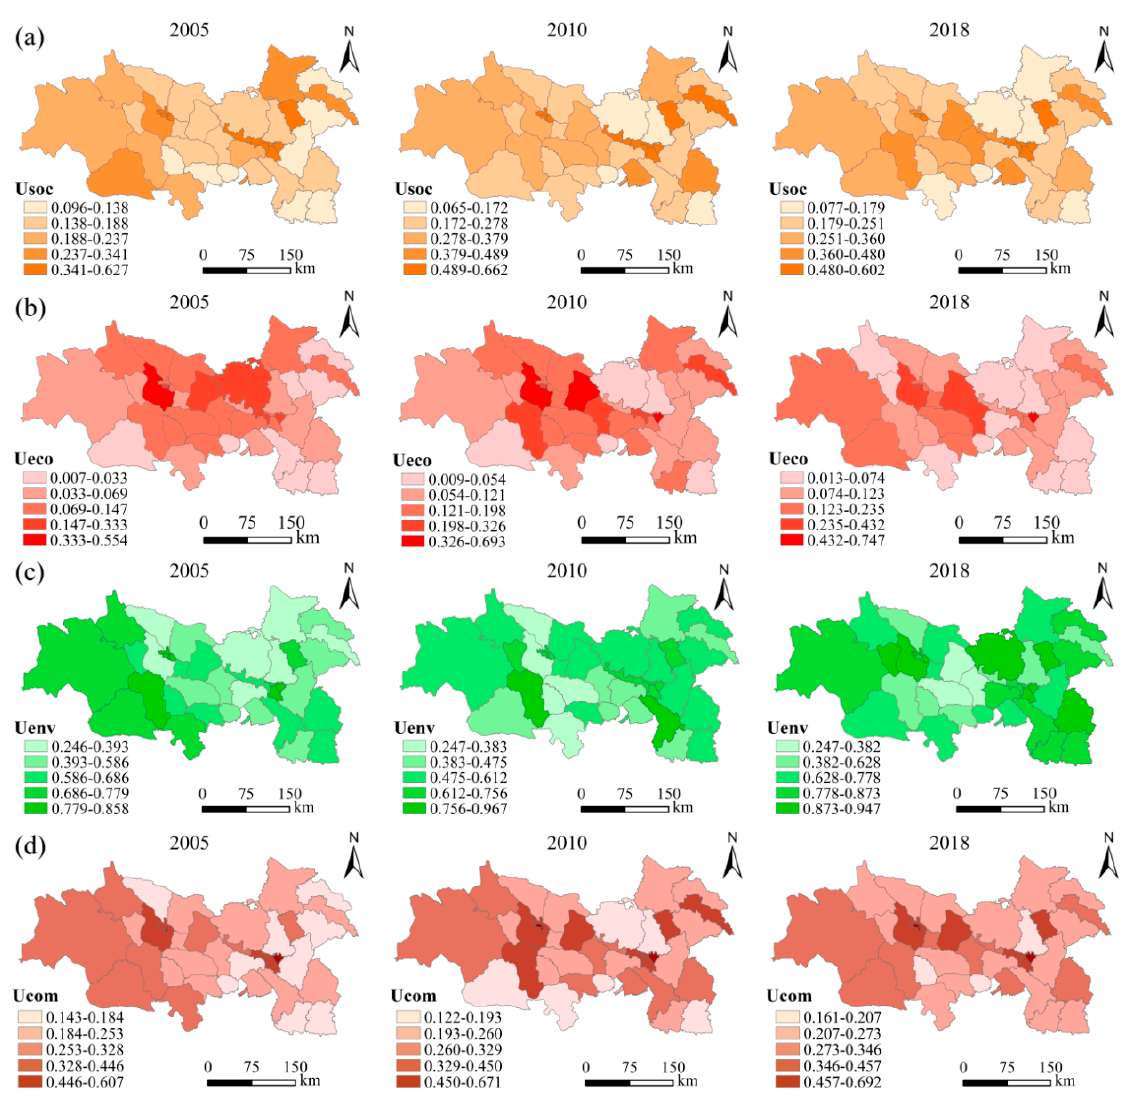
Figure 5. Spatial pattern of the CLUB in LXUA. ( a ) Social benefit, ( b ) Economic benefit, ( c ) Eco-environmental benefit, ( d ) Comprehensive benefit.